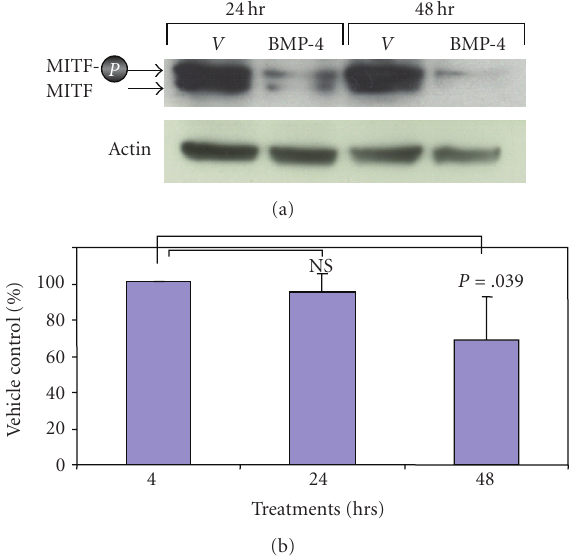
Figure 4: BMP-4 reduces the level of total MITF protein . (a) Paired cultures of melanocytes were treated with vehicle or BMP- 4 for 24 and 48 hours. At each time point, cells were harvested and immunoblot analysis using monoclonal antibody against MITF was performed. As the loading control, the membrane was immunoblotted for actin. One representative result from three separate experiments is shown. (b) In parallel, total RNA was isolated and quantitative Real-Time PCR was performed using specific primers against MITF-M as described under the Materials and Methods. Paired student t-test was performed for the statistical analysis.